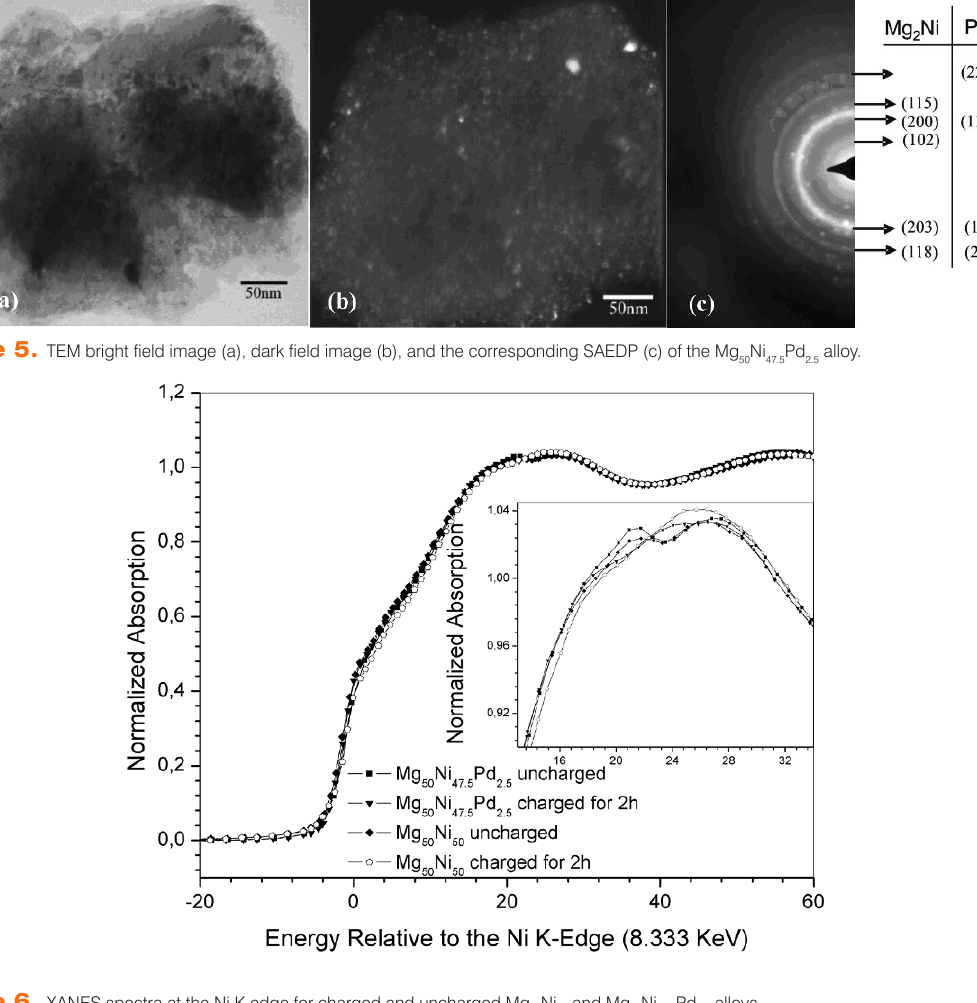
Ni and Mg Ni Pd 50 50 50 47.5 2.5